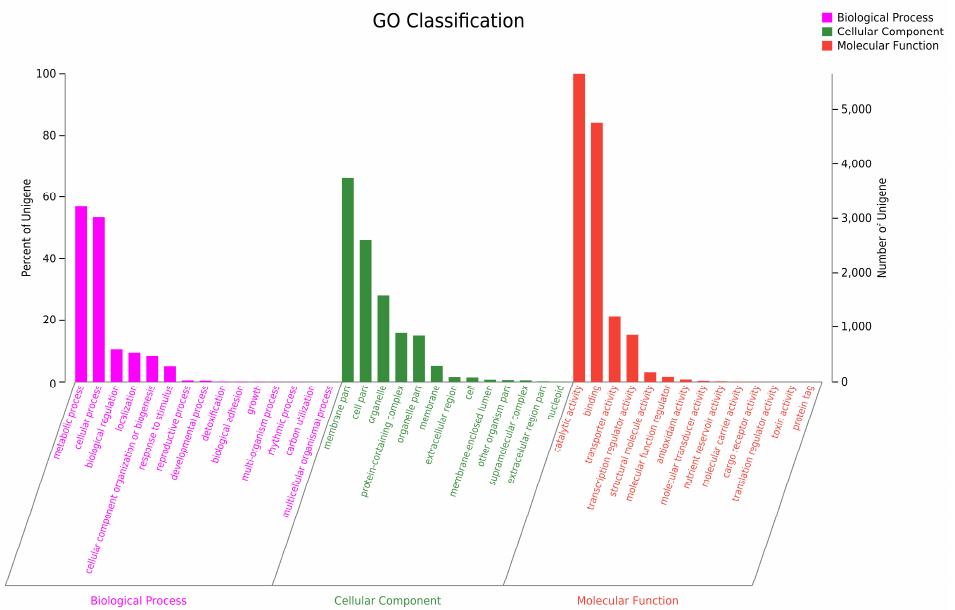
Figure 4. Gene Ontology (GO) analysis of D. alcacerensis CT-6 genes encoding the proteins.